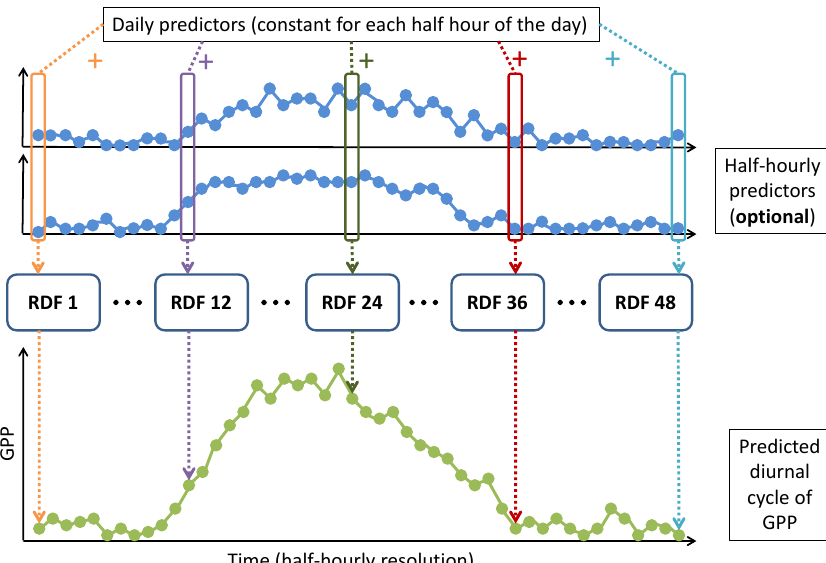
Figure 3. Visualization of the first prediction approach: an individual RDF regression model has been learned for each half hour of a day by just using training data from the corresponding half hour. Here, the predictions of half-hourly fluxes for a single day are visualized. The predictor variables are passed to the individual RDF regression models indicated by the arrows above the RDF models. Each RDF model computes an output for the corresponding half hour, which is shown by the arrows below the RDF models, such that the diurnal cycle is estimated by a conjunction of 48 different predictions from 48 different regression models. Note that this approach allows for predicting diurnal cycles only based on predictors with daily resolution (by ignoring the vertical colored bars in the upper part). However, predictors with half-hourly resolution can also be incorporated (by adding the corresponding half-hourly values indicated by the vertical colored